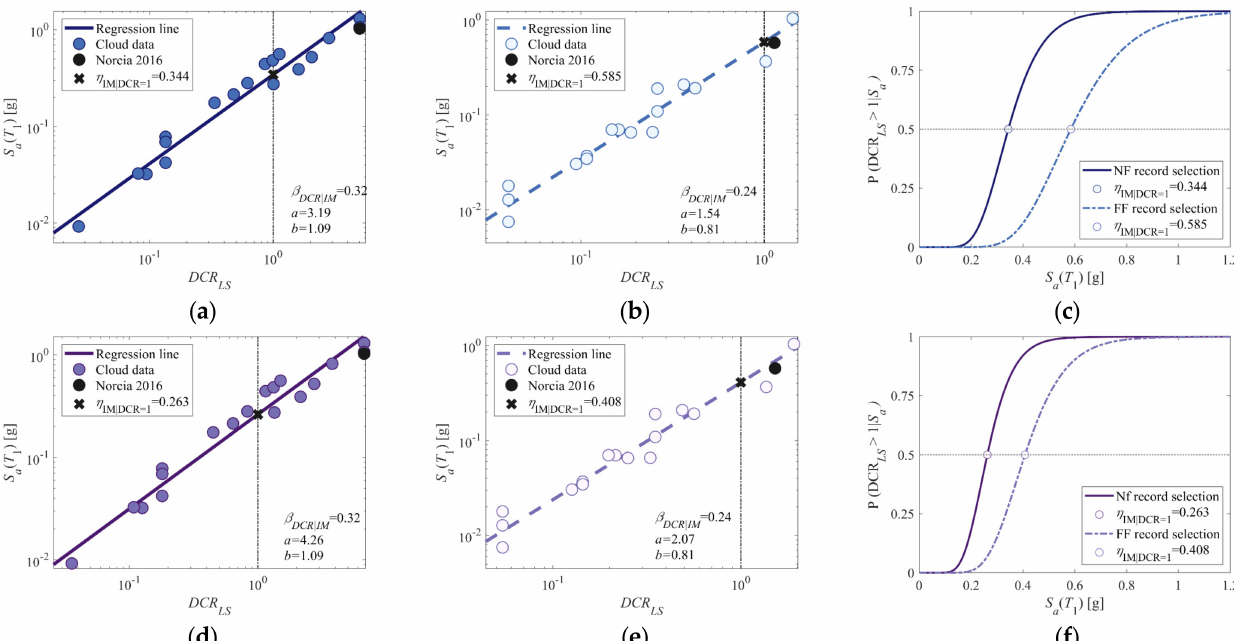
Figure 13. MPA-CA: ( a ) comparison among modal pushover analysis cloud data regressions for near-fault record selection and ( b ) far-field record selection; ( c ) comparison between the two fragility curves obtained considering only the first mode; ( d ) comparison among modal pushover analysis cloud data regressions for near-fault record selection and ( e ) far-field record selection, ( f ) comparison between the two fragility curves obtained considering the first and the second mode.